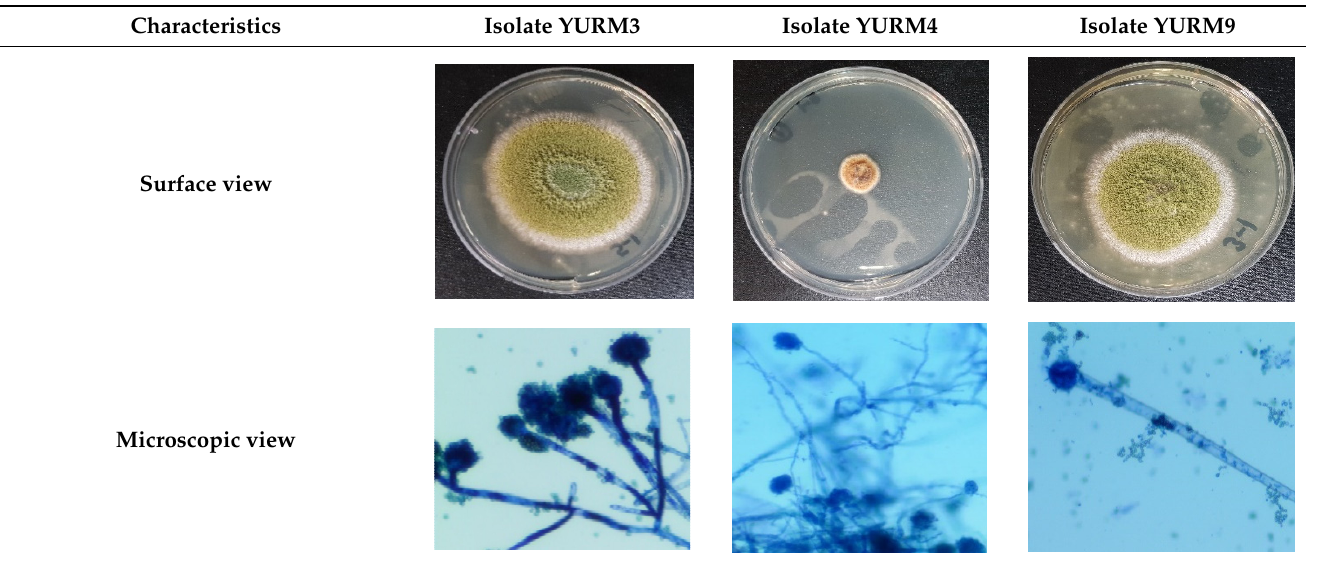
Figure 3. Aflatoxin production by Aspergillus flavus at three different stages of the doenjang preparation. ( a ) Aflatoxin production at the meju stage (Stage 1), primary fermentation (Stage 2), and secondary fermentation (Stage 3). ( b ) Time-dependent aflatoxin B1 production at the meju stage. Values in the bar graph represent the mean ± standard deviation of three independent experiments. ( c ) The combined results representing the time-dependent aflatoxin production by Aspergillus flavus at three different stages of doenjang preparation. NS: non-significant difference at p < 0.05. Table 1. Identification and general characteristics of aflatoxin-producing fungi isolated from doenjang and their mycotoxin production ability at different salt concentrations.